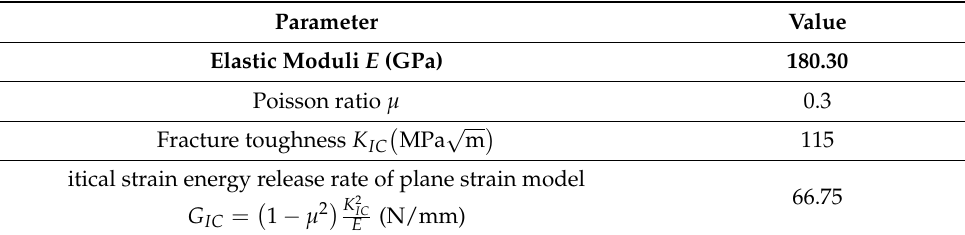
Table 2. Mechanical properties of × 80